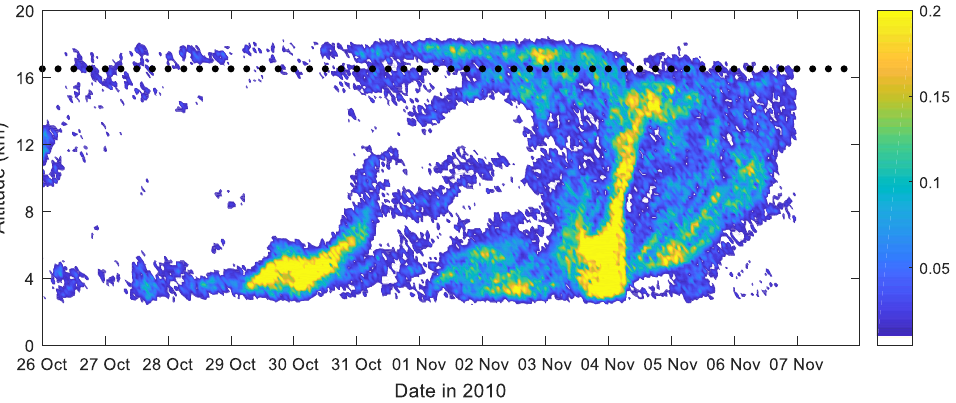
Figure 2. Merapi SO 2 emission time series (unit: kgm − 1 s − 1 ) derived from AIRS measurements using a backward trajectory approach (see text for details). The emission data are binned every 1h and 0.2km. The ticks for the horizontal axis mark 00:00UTC on each day. Black dots denote the height of the thermal tropopause (based on the ERA-Interim